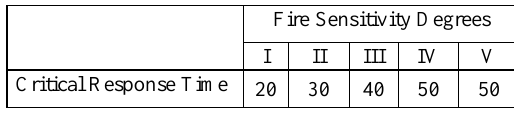
Table 1. Critical response time (min) (Akay et al.,